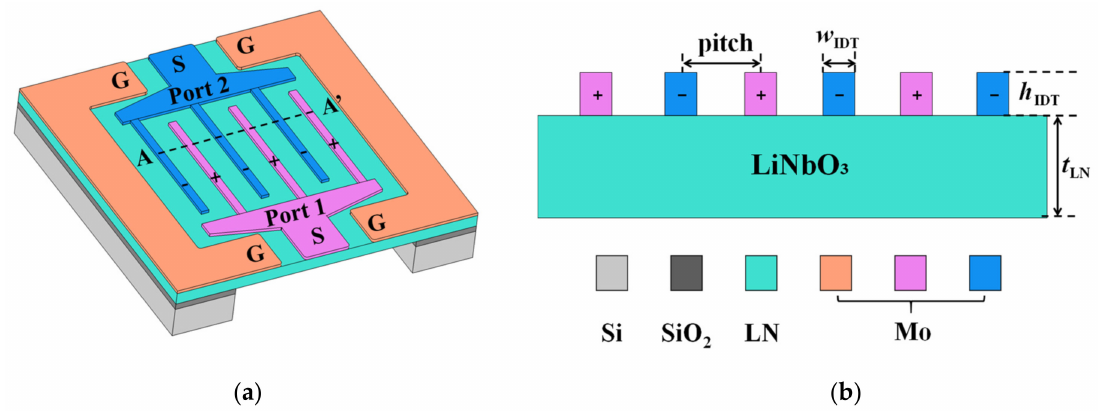
Figure 1. ( a ) The structural design of HF-LWR based on LN film; ( b ) Cross-sectional view of the active area of the resonator and the parameters